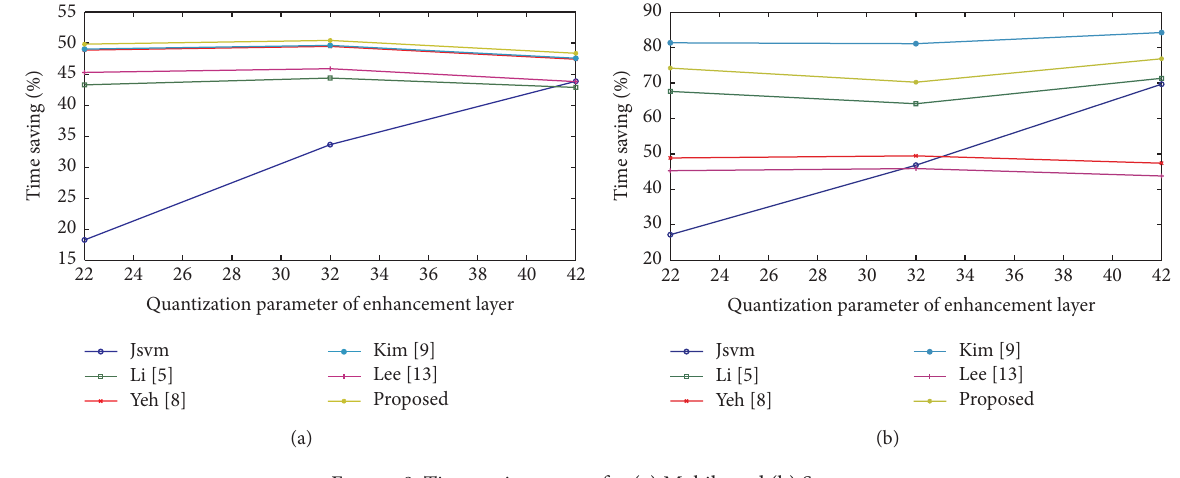
Figure 8: Time saving curves for (a) Mobile and (b)